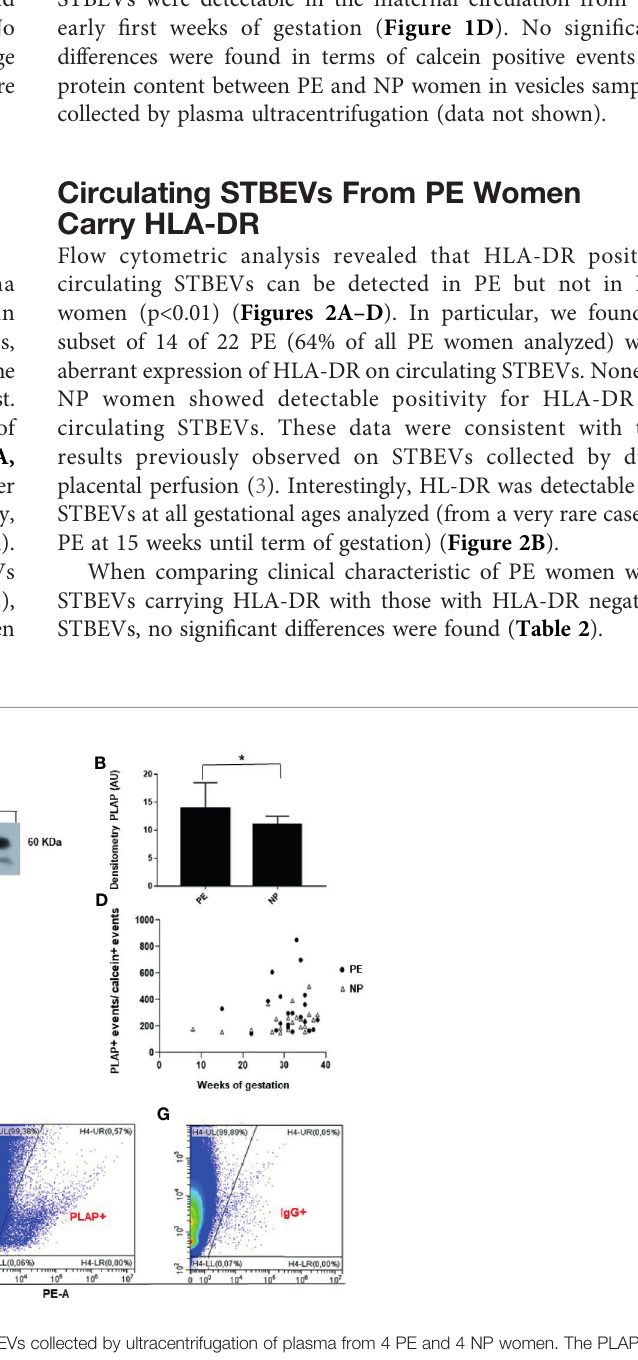
FIGURE 1 | (A) Representative Western blot showing PLAP positivity of STBEVs collected by ultracentrifugation of plasma from 4 PE and 4 NP women. The PLAP positive band identi fi es a signi fi cant content of STBEVs in all plasma samples analyzed. (B) Histogram showing densitometric analysis of immunoblots. Results are expressed as mean ± SD of 3 experiments. AU: arbitrary units. (C) Box plot showing signi fi cant higher average levels of PLAP positive (+), corresponding to STBEVs, detected in plasma of PE compared to NP women. PLAP positive events have been normalized to calcein positive (+) events. (D) Scatter plot showing STBEVs concentrations detected in both PE and NP women according to gestational age. (E – G) Representative fl ow cytometric analysis for PLAP positivity (+) of vesicles obtained from plasma of a PE (E) and a NP (F) woman. Levels of STBEVs (PLAP+ vesicles) in PE (E) were higher than in NP (F) . (G) Isotype IgG control used to assess the speci fi city of anti-PLAP antibody binding to STBEV in the same PE lady of panel (E) . NP, normal pregnant; PE, pre-eclamptic women; PLAP, placental alkaline phosphatase; STBEVs, syncytiotrophoblast-derived extracellular vesicles. *p < 0.5; **p <